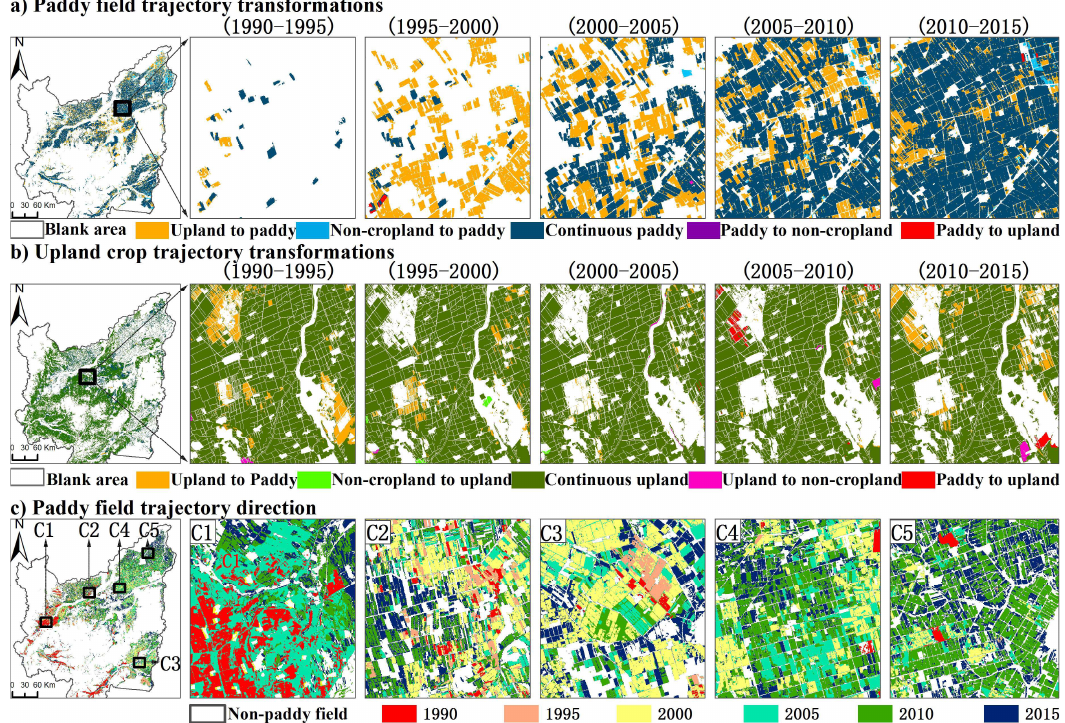
Figure 8. Trajectory transformations of the cropping patterns at the pixel level from 1990 to 2015. ( a ) Transition dynamics of the paddy field between two epochs. The figure shows a specific region from the black box in ( a ); ( b ) Transition dynamics of upland crop between two epochs. The figure shows a specific from the black box in ( b ); ( c ) The year (epoch) when a pixel in remote sensing image is identified as the paddy region for the first time. Five boxes were selected to show the trajectory directions of paddy dynamics at the pixel scale over five periods in private farming (two boxes: ( c1 ), ( c2 )) and state farming (three boxes: ( c3 ), ( c4 ), ( c5 )).